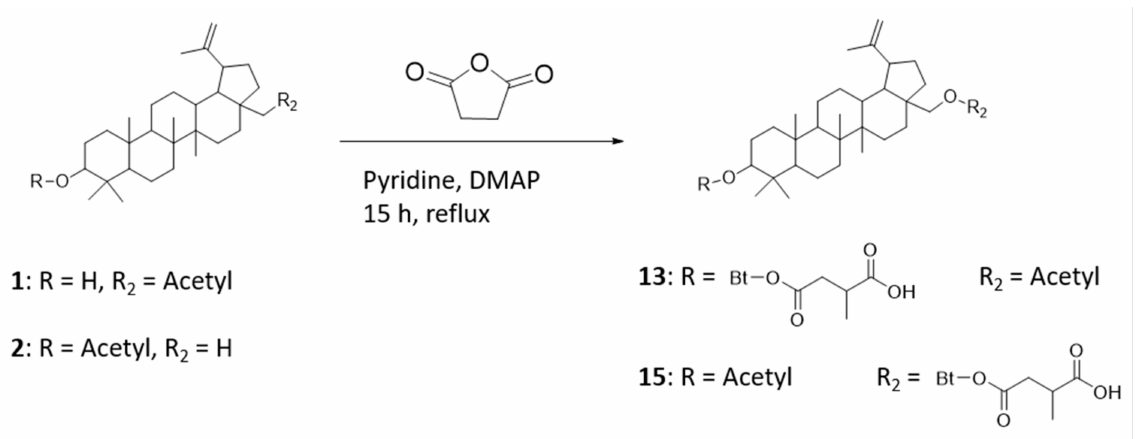
Figure 11. Preparation of 4-((1R)-3a-(acetoxymethyl)-5a,5b,8,8,11a-pentamethyl-1-(prop-1-en-2-yl)icosahydro-1H- cyclopenta[a]chrysen-9-yloxy)-2-methyl-4-oxobutanoic acid (compound 13 ) and 4-(((1R)-9-acetoxy-5a,5b,8,8,11a- pentamethyl-1-(prop-1-en-2-yl)icosahydro-1H-cyclopenta[a]chrysen-3a-yl)methoxy)-2-methyl-4-oxobutanoic acid (com- pound 15